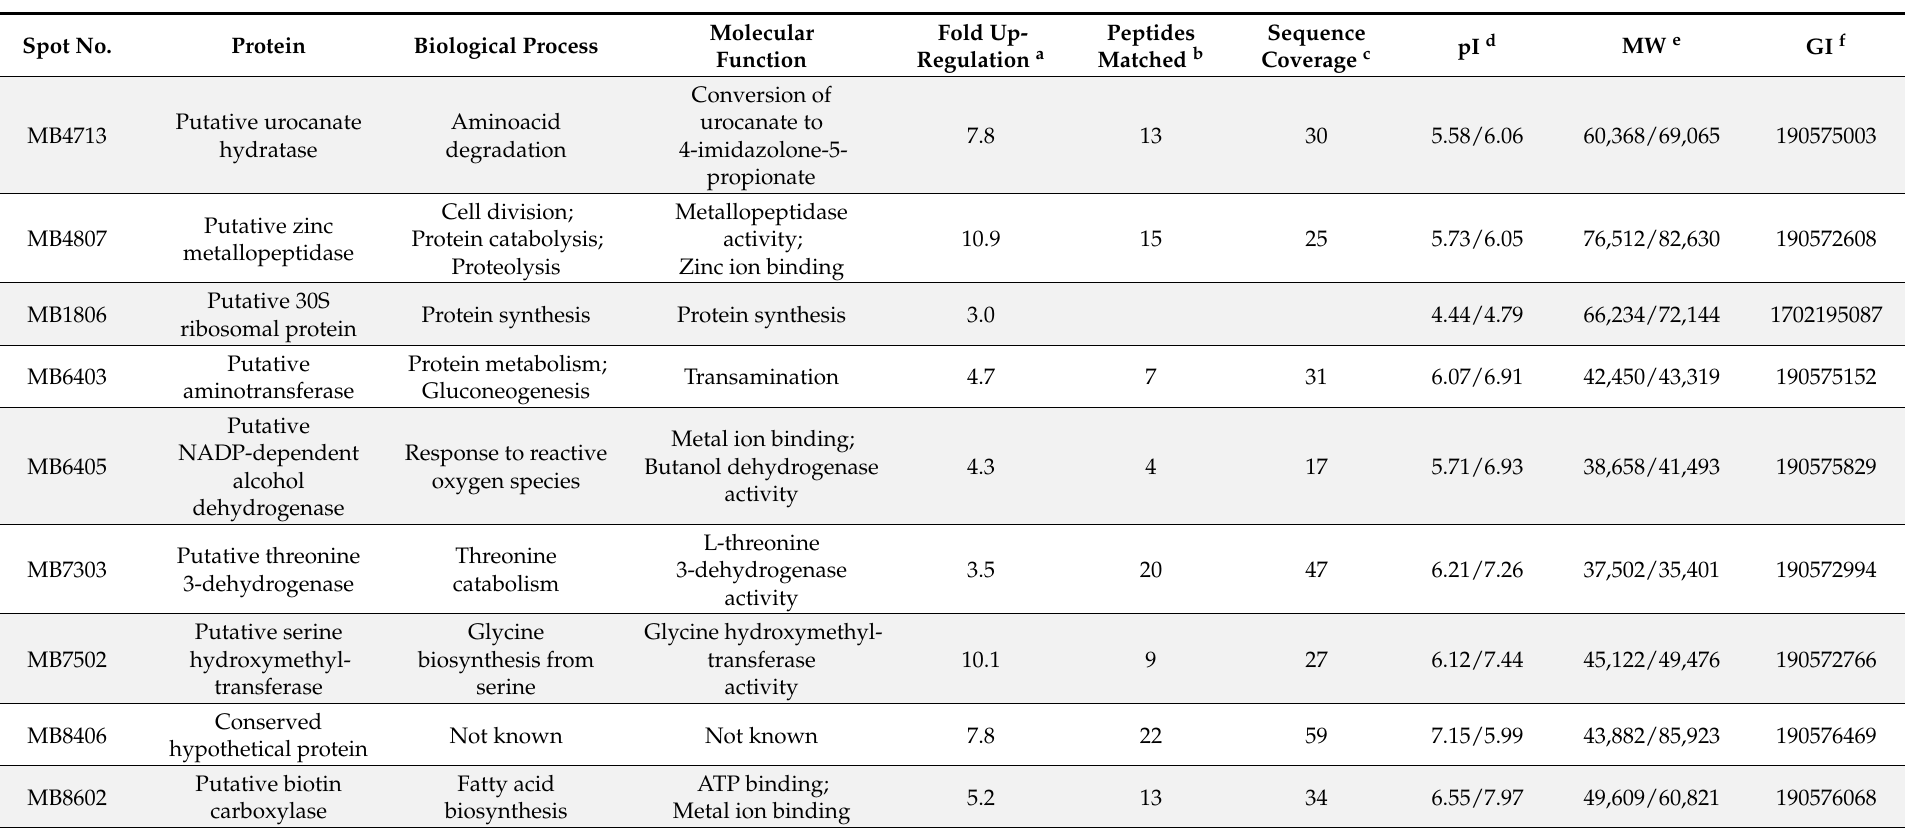
Table 2. Proteins (n = 9; signal > 1000 ppm; ≥ 3-fold vs . planktonic growth; p < 0.01, t -test) significantly upregulated in biofilm-grown S. maltophilia Sm126 cells. Spot